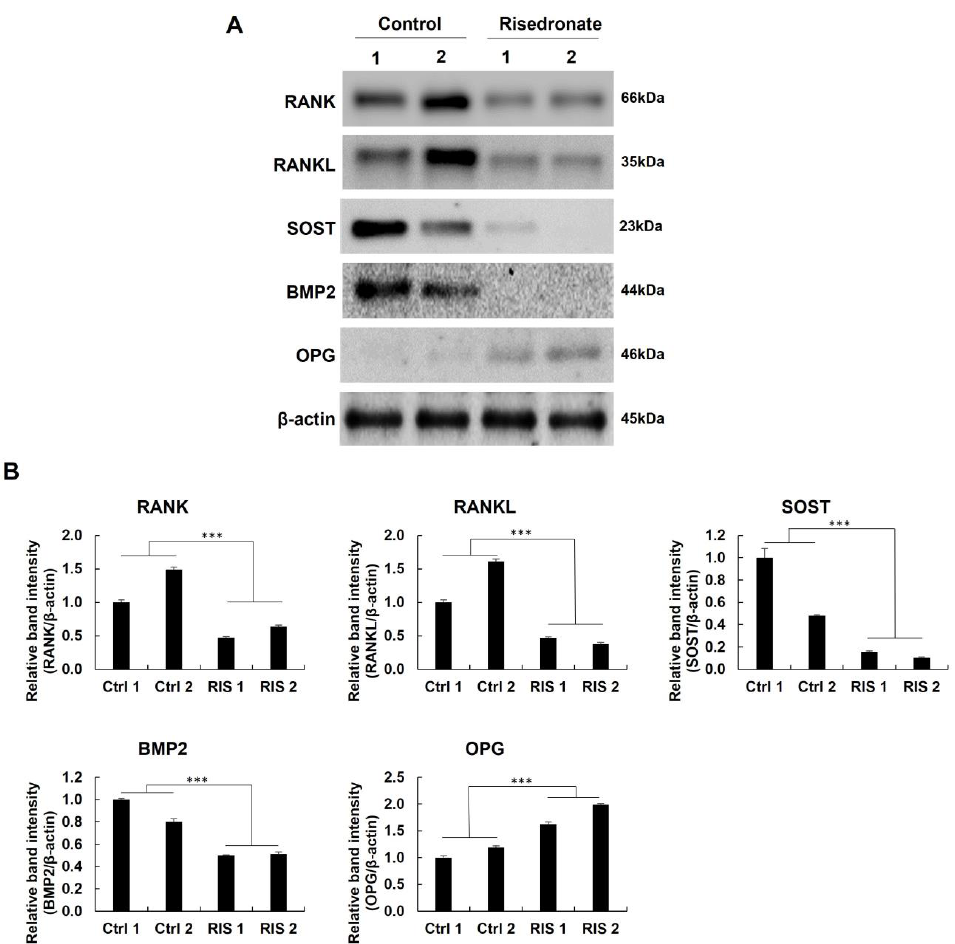
Figure 3. Western blotting results. ( A ) Band expression of RANK, RANKL, SOST, BMP2, and OPG. ( B ) Quantitative results of Western blotting for the expression of RANK, RANKL, SOST, BMP2, and OPG (*** p < 0.005).